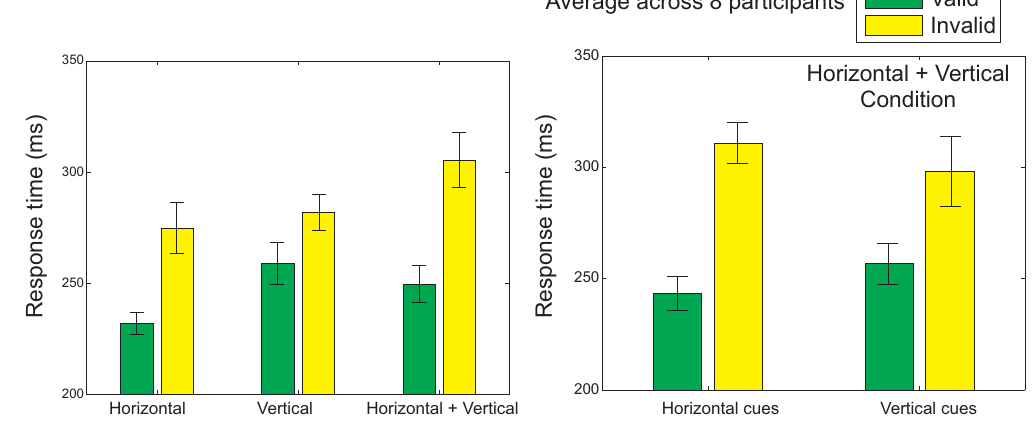
Figure 2 . Left: Average saccadic response time to the target after the presentation of a valid (green bars) or an invalid arrow cue (yellow bars), for the three different conditions (the horizontal and vertical conditions, where two possible target locations were used, and the combined horizontal and vertical condition, with four possible target locations). Right: Average response saccadic latencies for the combined horizontal and vertical condition, for the two different main cue directions (horizontal and vertical). The error bars show the standard error of the mean across participants.